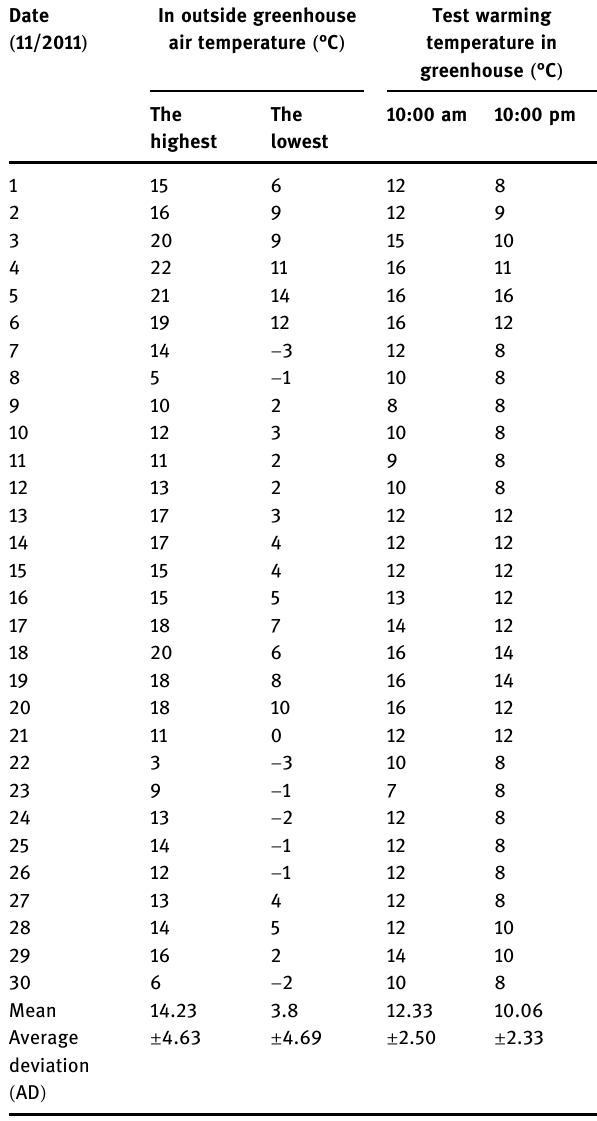
Table 6: Data of Test warming temperature in greenhouse at morning 10:00 and night